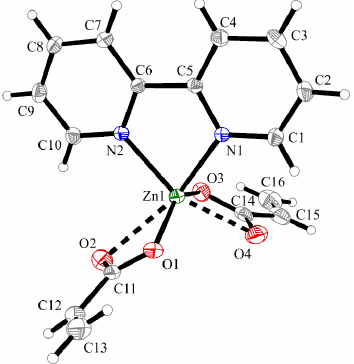
Figure 7. X-ray structure of [Zn(2,2 ′ -bipy)(C 3 H 3 O 2 ) 2 ] ∙ H 2 O ( 4 ). Thermal ellipsoids are shown with 15% probability. (Only molecule “A” of two found in the asymmetric unit is shown).